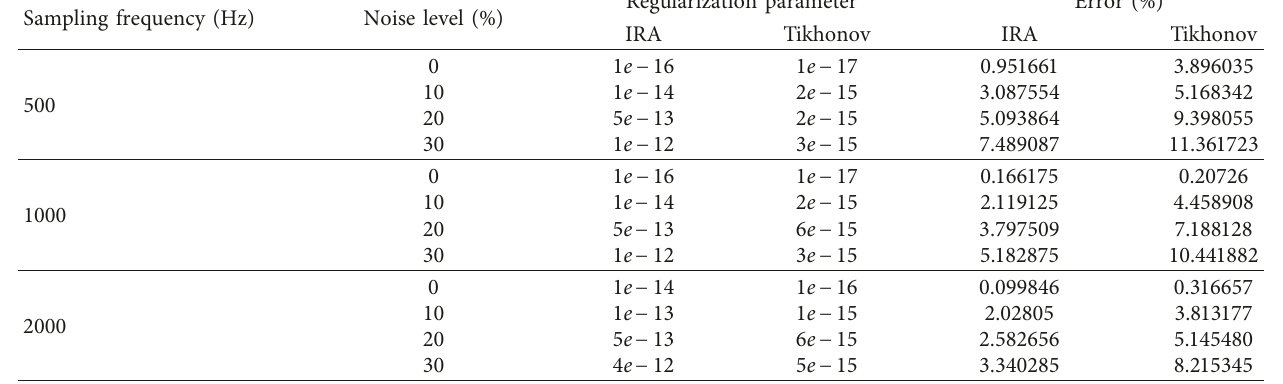
Table 2: Regularization parameters and relative accumulation errors of harmonic load. Sampling frequency (Hz)